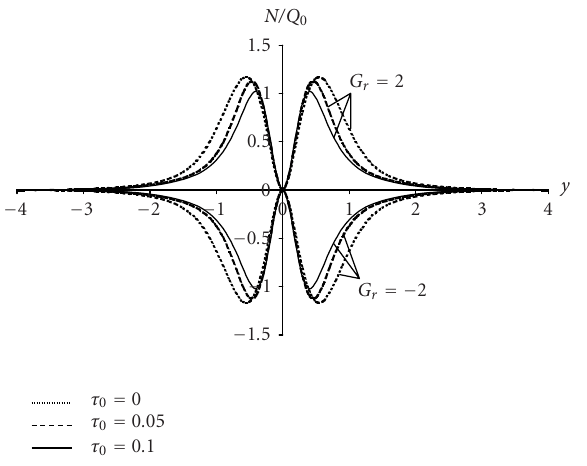
Figure 7.6. The angular velocity distribution for di ff erent values of τ 0 for the whole-space